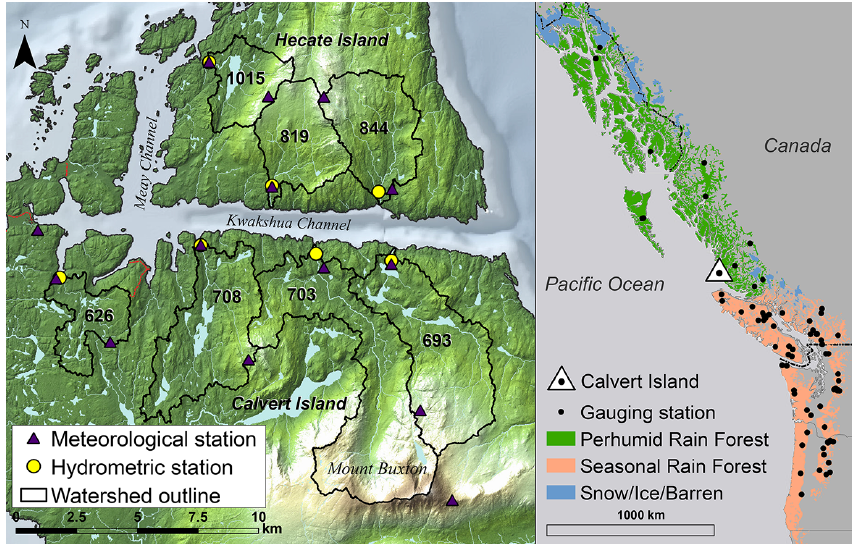
Figure 1. The seven gauged watersheds at Calvert and Hecate islands on the outer coast of the northeast Pacific coastal temperate rainfor- est (NPCTR) of North America. Active government-operated gauging stations in small watersheds (Environment Canada stations, with a gross drainage area of < 25km 2 , and United States Geological Survey (USGS) stations, with 24h average summer flow < 1.5m 3 s − 1 ) are shown to indicate the lack of gauging stations measuring outer coast small watersheds. The terrain relief map was created by Arriola and Holmes (2017). Regional rainforest cover is derived from the original rainforest distribution mapping of Ecotrust (1995), which reflects the rainforest subzones of Alaback